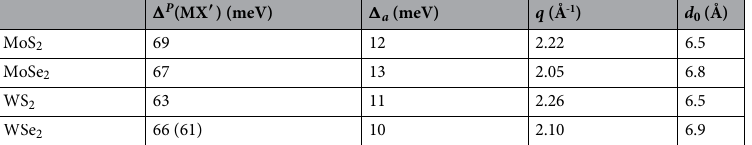
Table 4. Vacuum energy difference across MX ′ TMD bilayers, (cid:31) the general configuration dependence of the potential drop, � The value in parantheses for WSe 2 is that found above using the VASP code, with only ∼ 10% variation between different codes in the prediction for (cid:31)